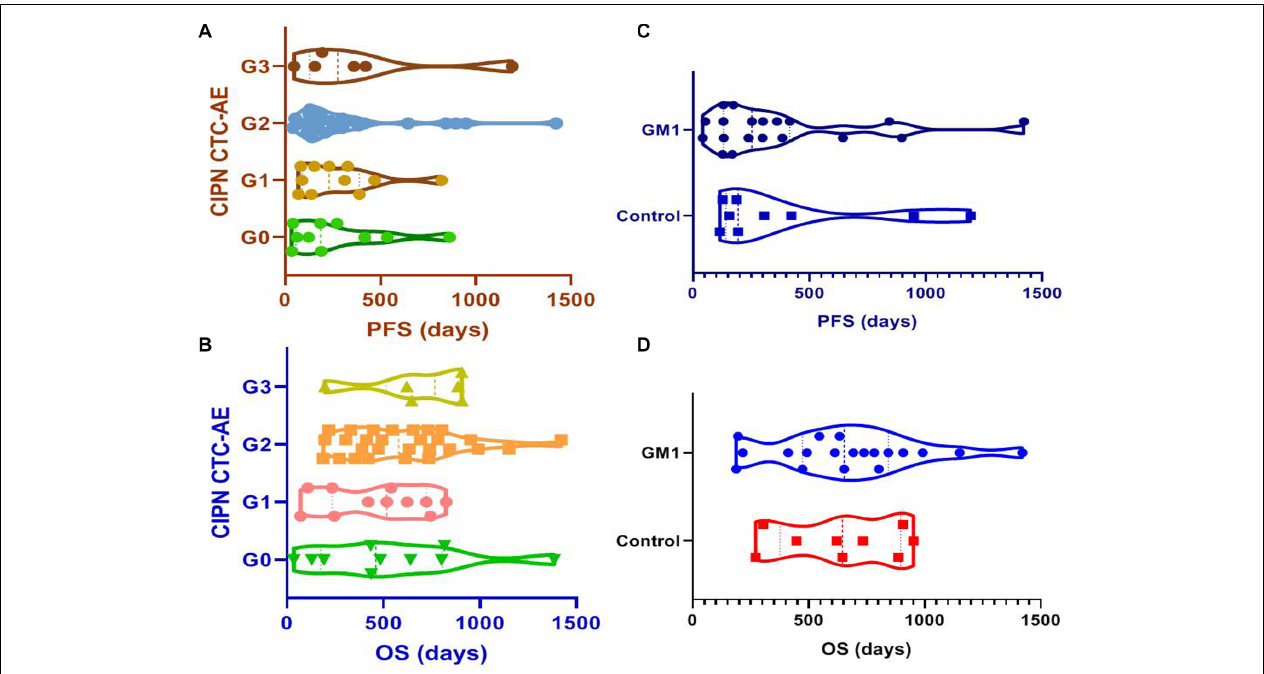
FIGURE 4 | IRC-assessed PFS among patients with diverse grades of CIPN (A) , IRC-assessed PFS between GM1 and control groups (B) , IRC-assessed OS among patients with diverse grades of CIPN (C) , IRC-assessed OS between GM1 and control groups (D)